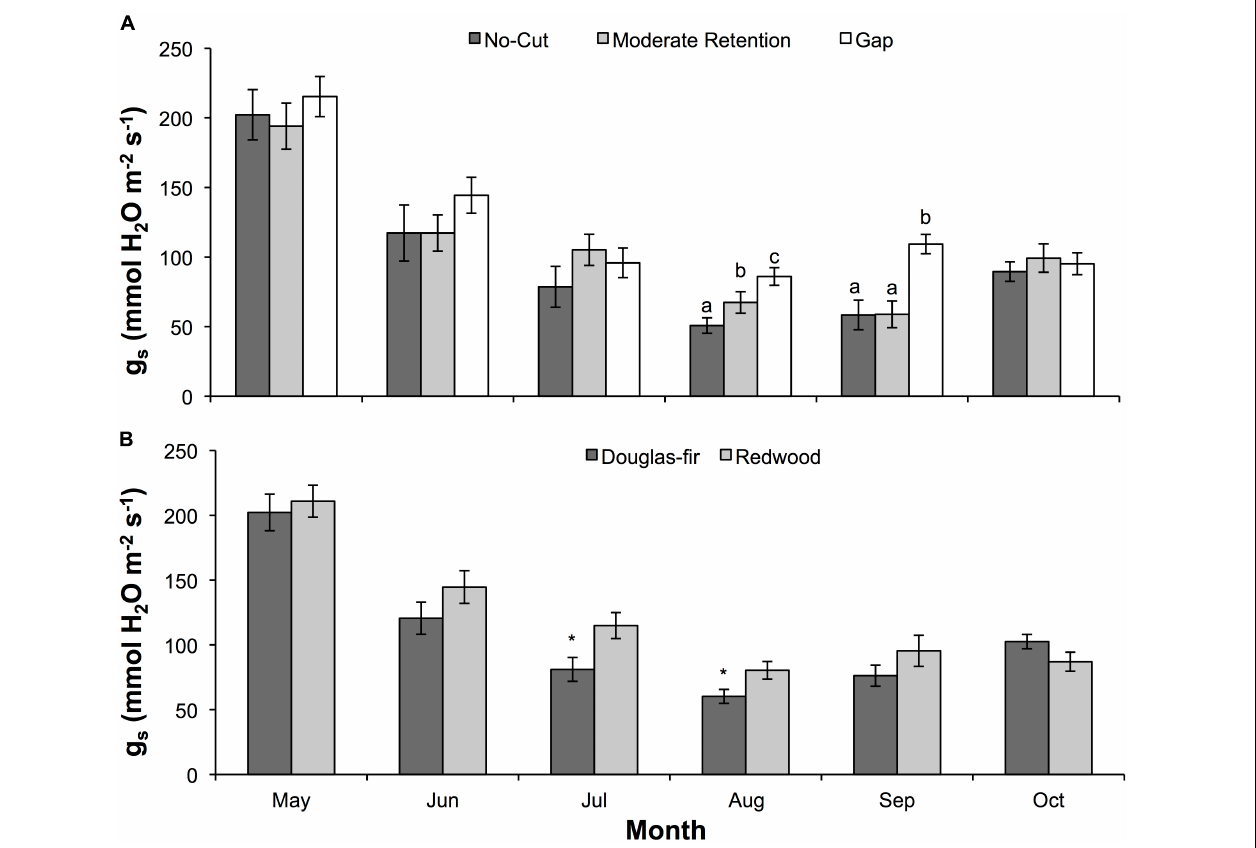
FIGURE 2 | Mean ( ± SE) stomatal conductance of water vapor (g s ) during the 2016 (second) growing season for Douglas-fir and redwood seedlings planted after partial harvesting in Maple Creek, CA. (A) Stomatal conductance among treatments for both species pooled, and (B) stomatal conductance between species for all treatments pooled. In panel (A) , within a month, treatments not sharing the same letter are significantly different; in panel (B) , asterisks represent a significant difference between